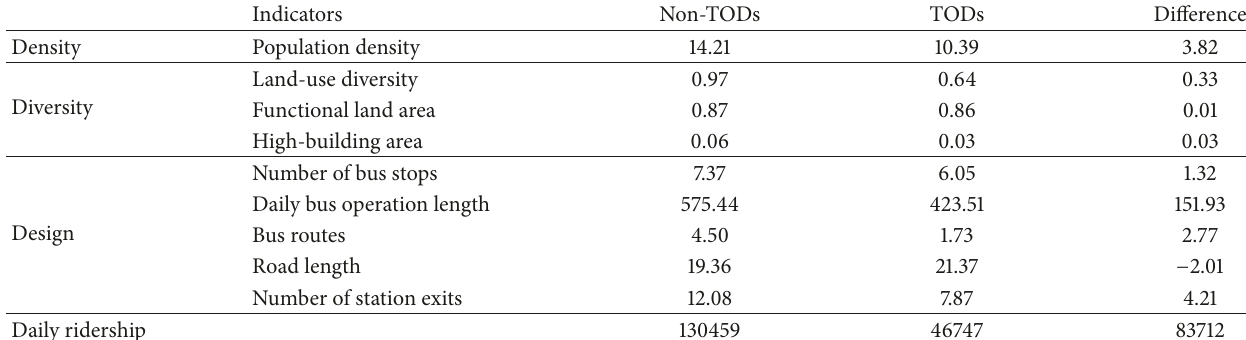
Table 2: Means of the indicators of non-TOD and TOD stations.